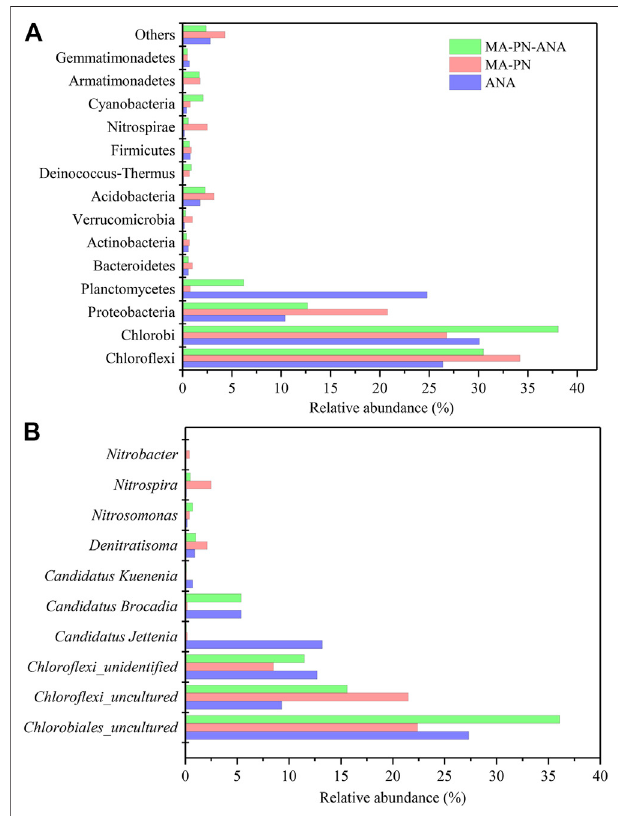
FIGURE 10 | The relative abundance of dominant functional bacteria at phylum (A) and genus (B) levels in three reactors. ANA, MA-PN, and MA-PN- ANA denote anammox reactor, microalgae-intensi fi ed partial nitri fi cation reactor, and algammox reactor, respectively.